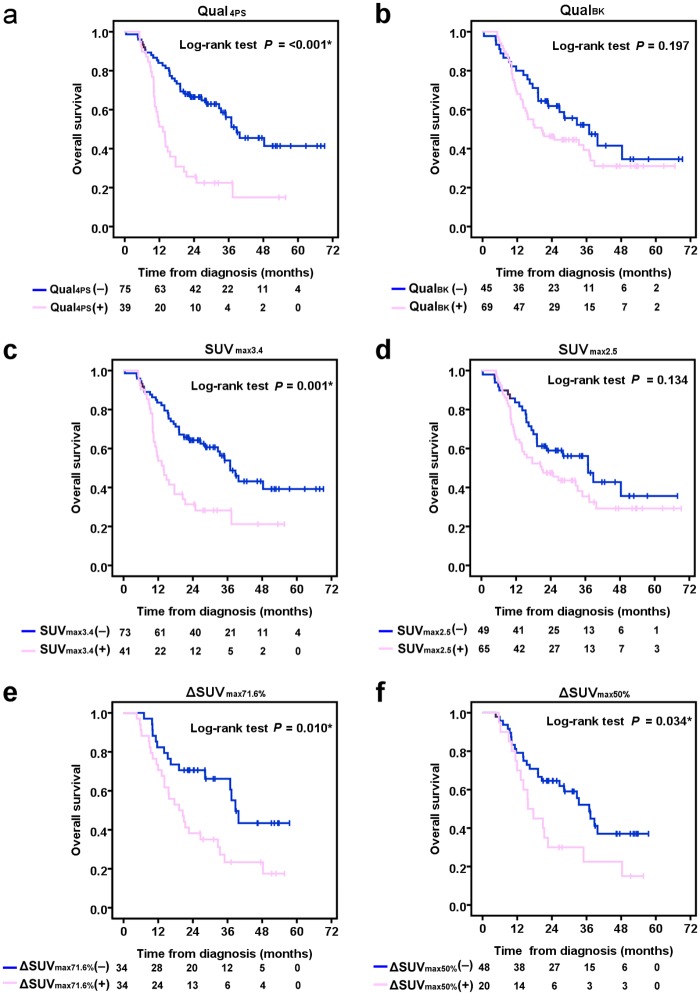
Kaplan-Meier plots of overall survival based on post-CRT FDG PET scans using (a) Qual4PS, (b) QualBK, (c) SUVmax3.4, (d) SUVmax2.5, (e) ΔSUVmax71.6%, and (f) ΔSUVmax50% cut-offs.